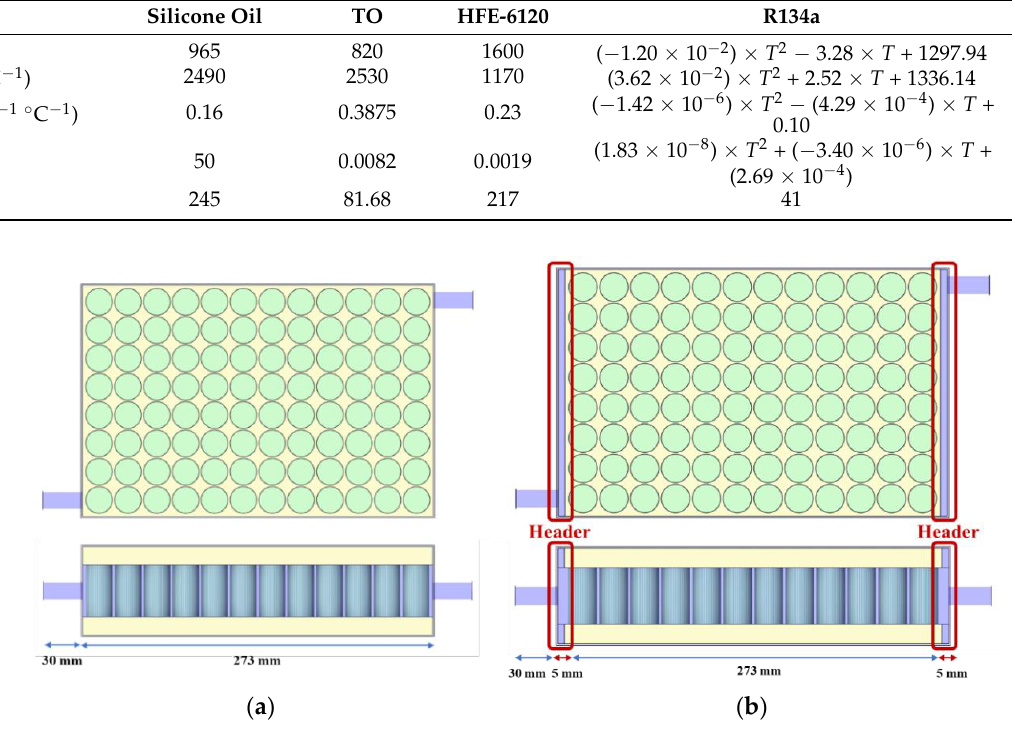
Figure 2. Modeling of the battery module according to the changing header width: ( a ) Header width = 0 mm; ( b ) Header width = 5 mm.